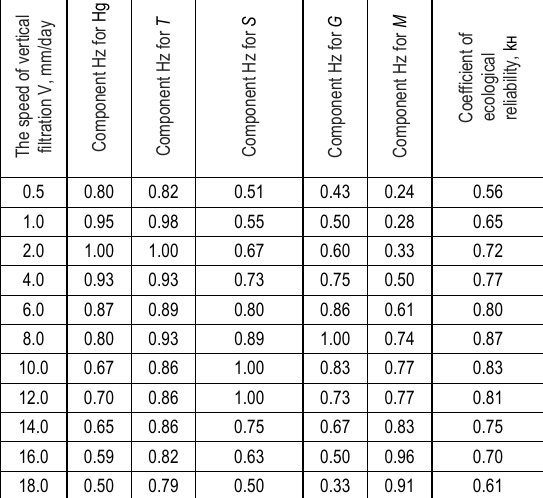
Table 2. Assessment of ecological reliability of project solutions depending on the speed of vertical filtration on rice